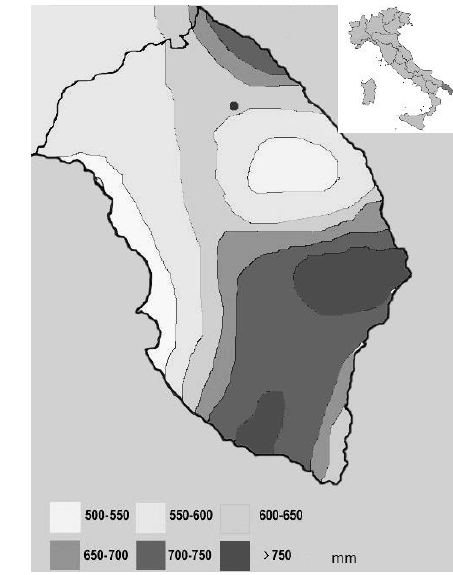
Figure 1. Salento peninsula with averaged 1921–1996 precipita- tion distribution (mm) (adapted from http://www.supermeteo.it). The dot indicates the measurements